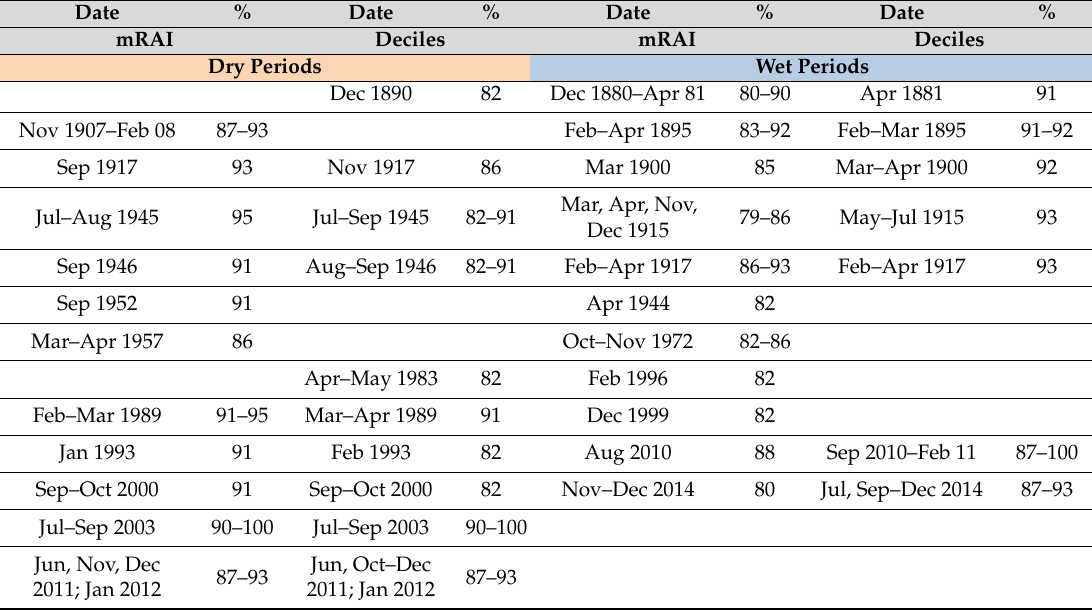
Table A8. Sub-region South Eastern Europe—overview on the TOP20 months with the highest spatial extent of dry and wet periods within the study period